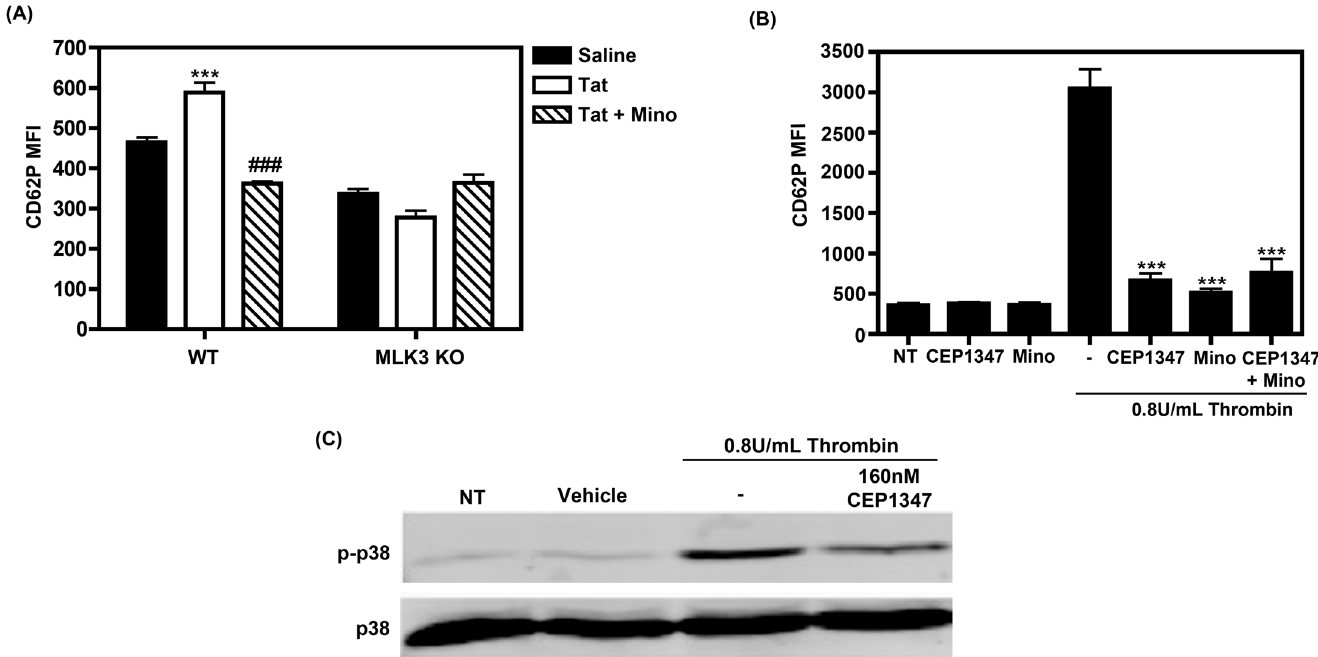
Fig 6. MLK3 is involved in platelet activation. (A) Platelet activation was measured by analyzing CD62P via flow cytometry from whole blood collected from WT or MLK3 KO mice after exposure to the indicated treatments (n = 4 for each group). This data set was compared using a two way ANOVA statistical test followed by Bonferroni ’ s test for multiple comparisons, where *** denotes p < 0.0001 saline treatment compared to Tat treatment and ### denotes p < 0.0001 for minocycline treatment compared to Tat treatment. (B) Isolated, washed platelets were subjected to the indicated treatments and assessed for platelet activation via CD62P MFI analysis. This data set was compared using a one way ANOVA statistical test followed by Bonferroni ’ s test for multiple comparisons, where *** denotes p < 0.0001. Data shown is representative of three separate experiments. (C) Isolated, washed platelets were subjected to 5-minute thrombin treatment with or without increasing concentrations of MLK3 inhibitor, CEP1347, as shown. Whole cell lysates were subjected to immunoblot analysis using phosphorylated p38 MAPK or total p38 MAPK-specific antibodies. Data shown is representative of a single experiment that was repeated three